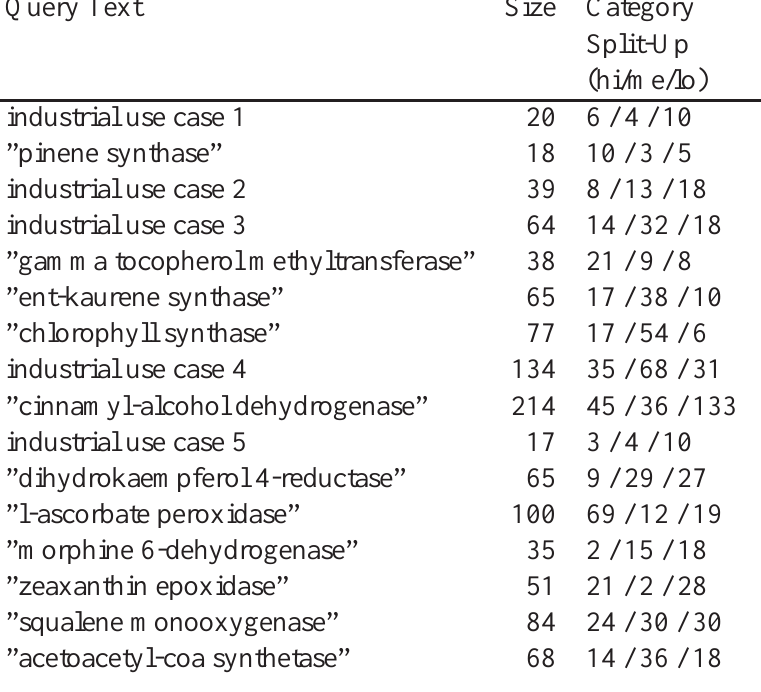
Table 2: Overview of the training data